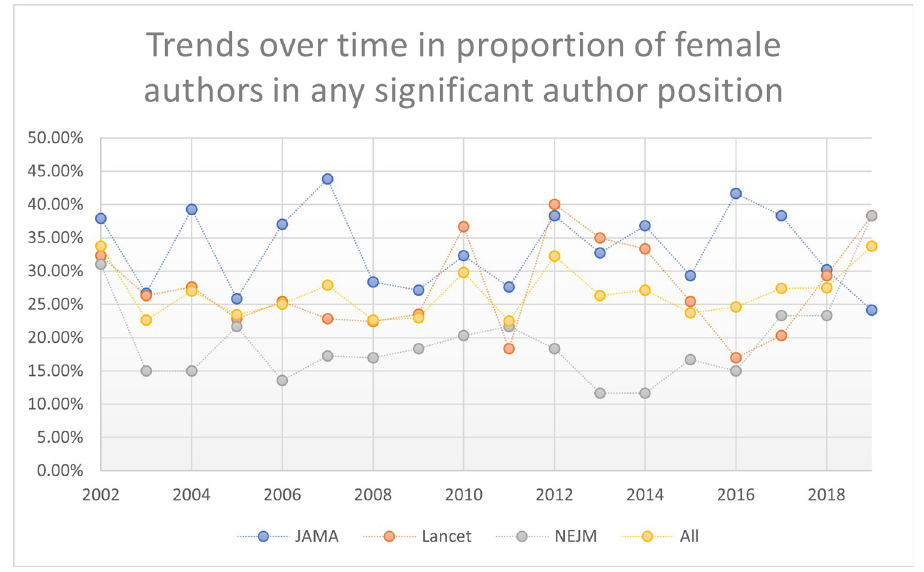
Fig 5. Trends over time in proportion of any significant authors (first, second, or last author) by gender.